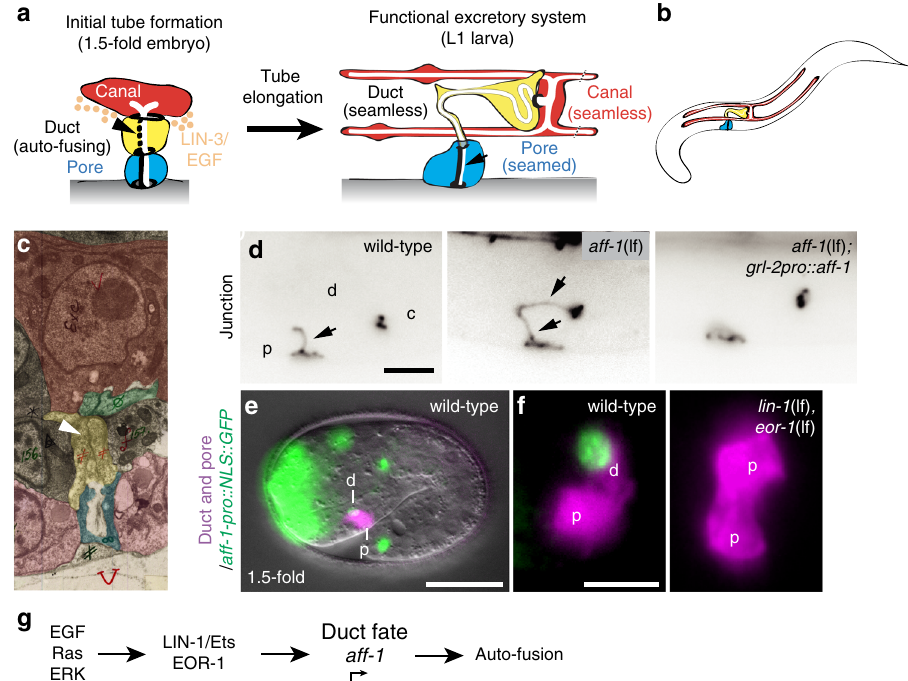
Fig. 1 EGF-Ras signaling drives aff-1 expression to promote auto-fusion in the excretory duct. a Schematics of excretory system tube development. Prior to the 1.5-fold stage of embryogenesis, the excretory duct (yellow) and pore (blue) cells each wrap to form unicellular tubes by establishing self-contacts and auto-junctions. A LIN-3/EGF signal is emanating from the excretory canal cell (in red). The excretory pore cell maintains its auto-junction (thick dark line) and the excretory duct auto-fuses (arrowhead and dotted line), forming a seamless tube. After tube formation the cell morphologies change, with elongation of the duct and canal cells. b Schematic of an early L1 larva showing the three tube cells of the excretory system. c Transmission electron micrograph of a 1.5-fold stage embryo showing excretory cells, from unpublished data by C. Norris and D. H. Hall. Prior to auto-fusion, the duct in yellow has an auto-junction (white arrowhead). In red, the canal cell, in green an excretory gland cell, in blue, the pore cell and in pink hypodermal cells. d Excretory system junctions visualized with ajm-1::gfp . In wild-type, the pore (p) has an auto-junction (arrow), but the duct (d) and canal (c) do not. In aff-1 ( tm2214 ) mutants, both duct and pore cells have auto-junctions (arrows). In aff-1 ( tm2214 ) mutants with the transgene grl-2pro::aff-1 expressed in duct and pore, both cells auto-fuse. e Wild-type 1.5-fold embryo-expressing aff-1pro ::NLS-GFP (green) in the duct (d) but not pore (p). f Unlike wild-type, in lin-1 ( n304 ) eor-1 ( cs28 ) double mutants, both cells adopt a pore-like morphology (ref. 30 and Supplementary Fig. 2) and neither cell expresses aff-1pro ::NLS-GFP. g EGF-Ras-ERK signaling promotes duct fate and aff-1 expression. Scale bar, d , f = 5 μ m and e = 10 μ